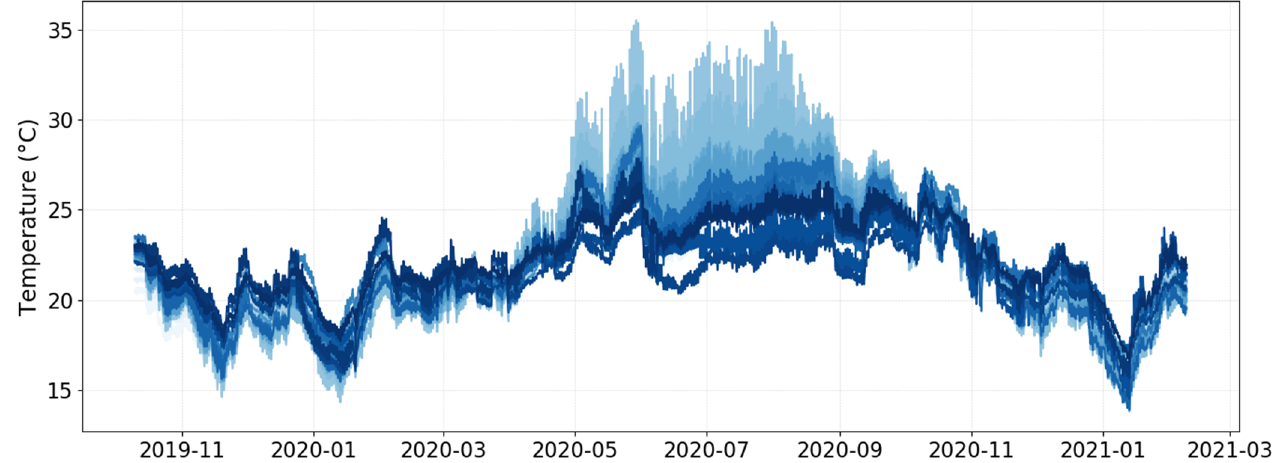
Figure 2. Raw trajectories of the time series of temperature recorded every 5 min by the 27 data-loggers installed in l’Almoina Museum from 10th October 2019 until 8th February 2021. Some time series contains missing values.